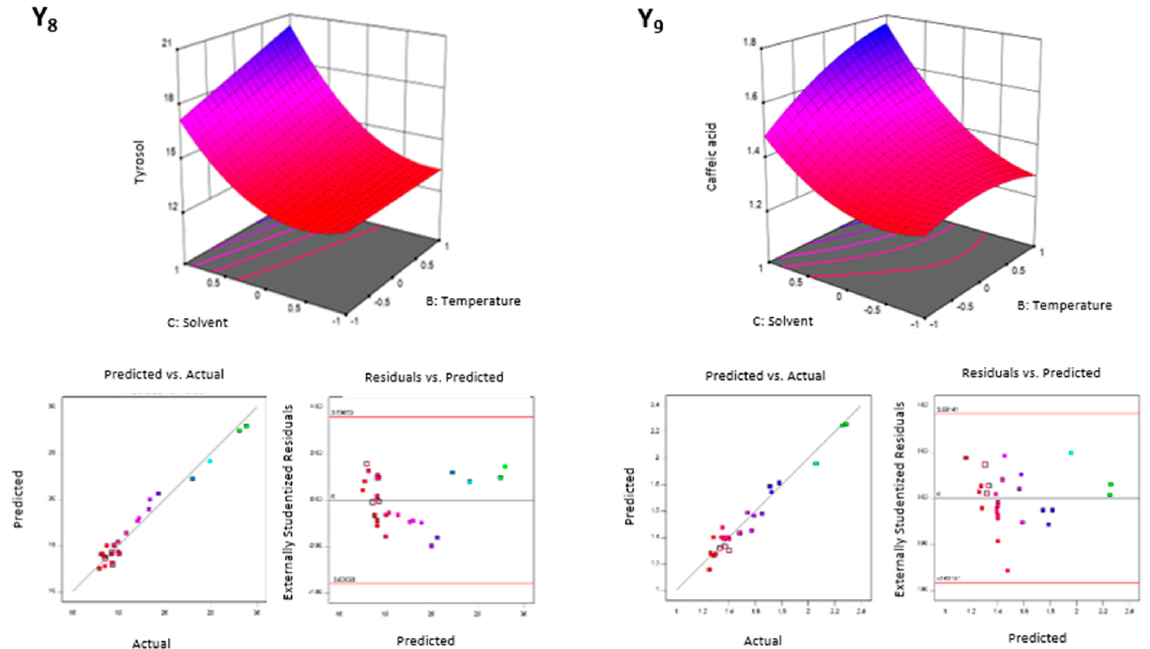
Figure 4. RSM graphs from the responses Y 8 (Tyrosol, mg/g Ext) and Y 9 (Caffeic acid, mg/g Ext), with statistical diagnostic representations. Each graph displays temperature vs solvent factors, with a time factor adjusted to 0, along with two statistical diagnostics attached. On the left, the graphical representation of the adjustment between predicted vs actual points, and on the right, the graphical representation of residuals vs predicted points.